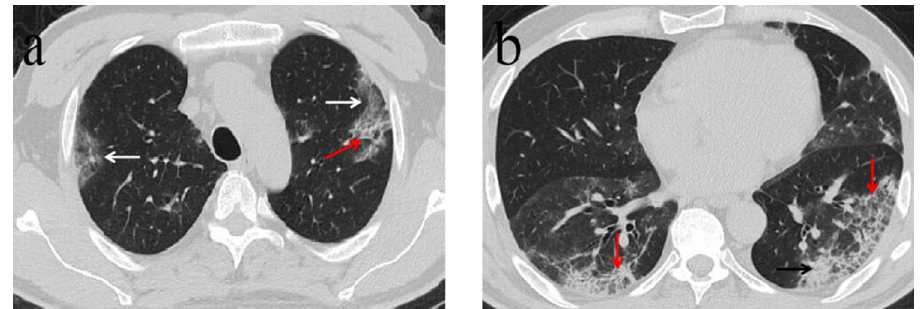
Figure 2. A 57-year-old man with a history of recent travel to Wuhan presented with fever for 10 days. ( a , b ) Non-contrast enhanced chest CT showed multiple peripheral patchy ground glass opacities (white arrows) and crazy-paving pattern (red arrow) in both lower lobes. CT scan also demonstrated consolidation in the left lower lobe (black arrow). CT involvement score was 11.